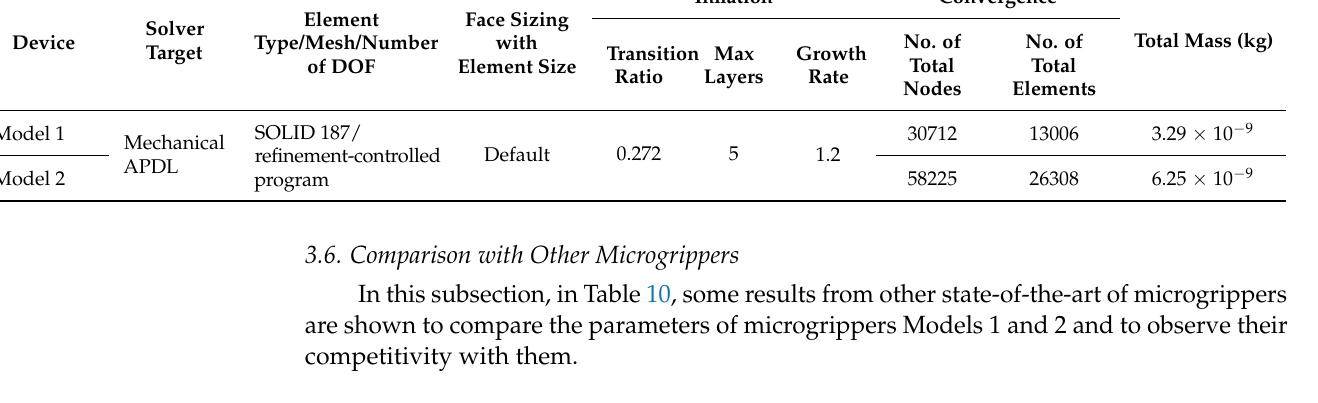
Table 10. Comparison with other microgrippers.